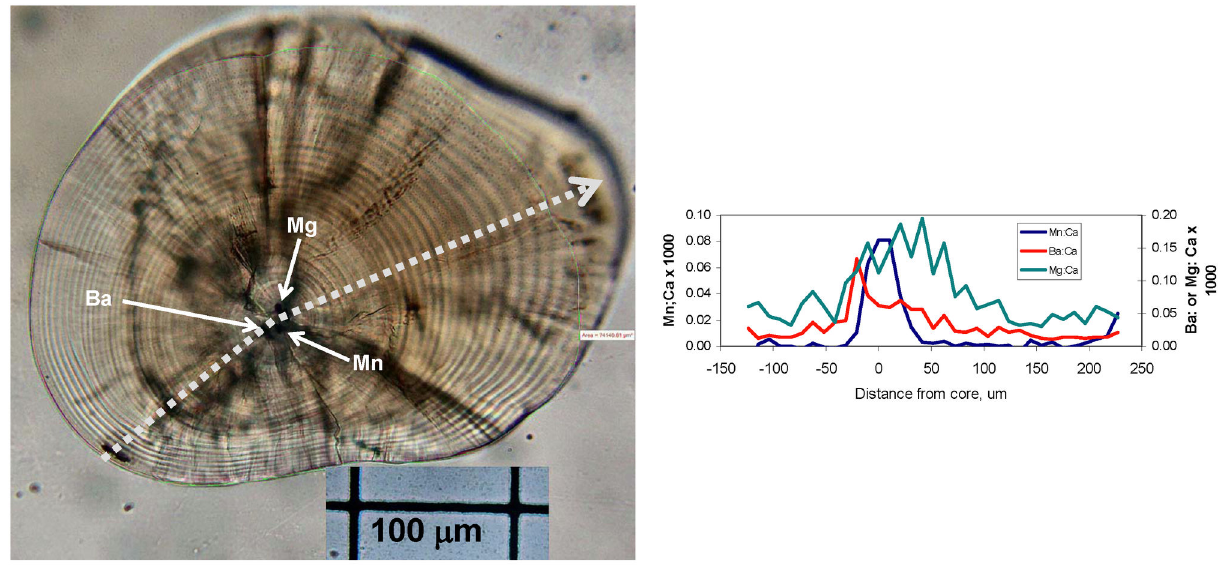
Figure 7. Otolith from a 25-mm, 30-day-old humpback chub captured in the Little Colorado River, June 2010. Note the presence of three primordia (arrows) that appear to be elevated in Ba, Mn, and Mg respectively. Dotted line shows direction of laser track but its width is not to